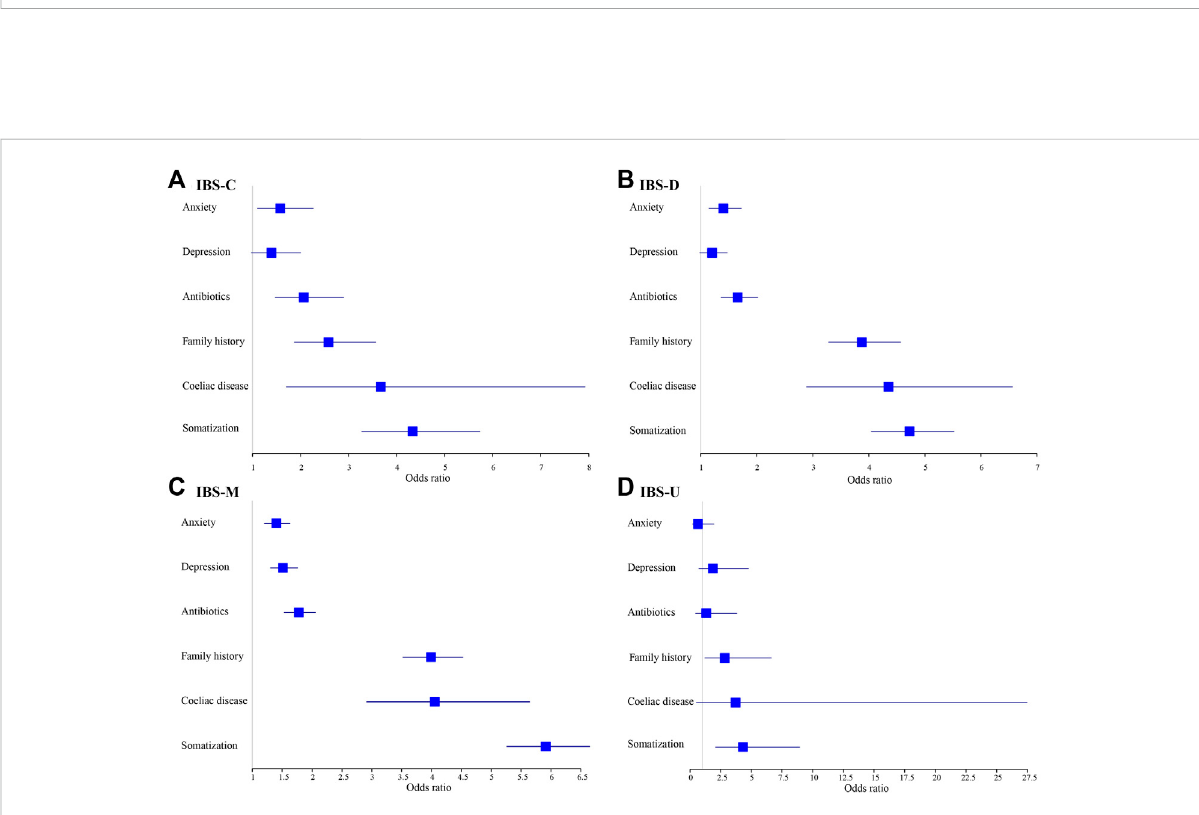
FIGURE 5 Models of factors associated with IBS subtypes for males and adjusted for age and socioeconomic status. (A) IBS-C. (B) IBS-D. (C) IBS-M. (D) IBS-U.